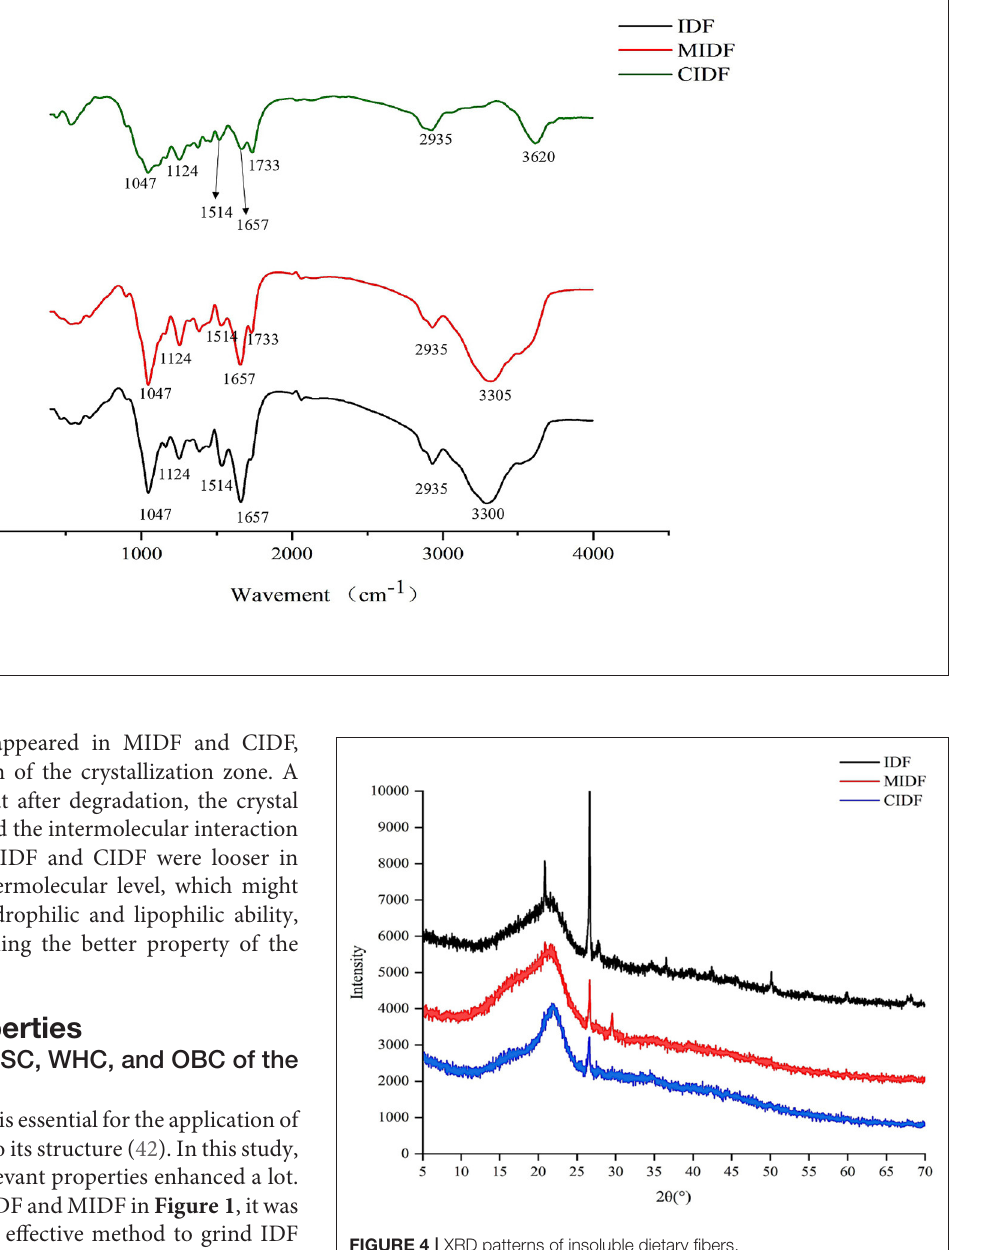
FIGURE 4 | XRD patterns of insoluble dietary